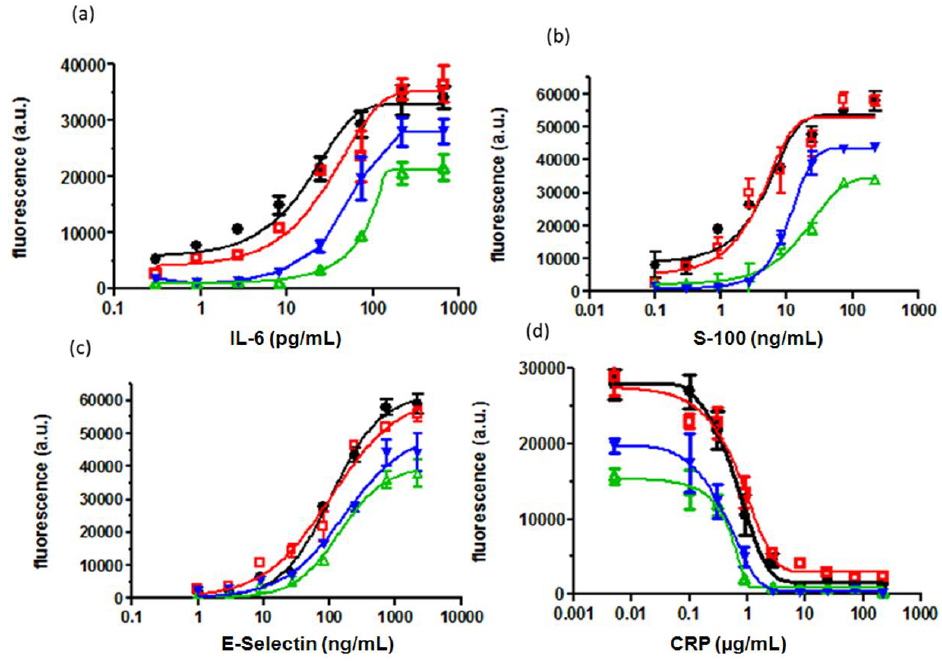
Figure 2. Calibration curves for ( a ) IL-6 ( b ) S-100 ( c ) E-Selectin and ( d ) CRP. The black curve ( ) displays the 10 µL assay and the red curve ( ) shows the 50 µL assay when adding strep.MPs; the blue curve ( ) displays the classical 50 µL assay and the green curve ( ) displays the 10 µL assay without addition of